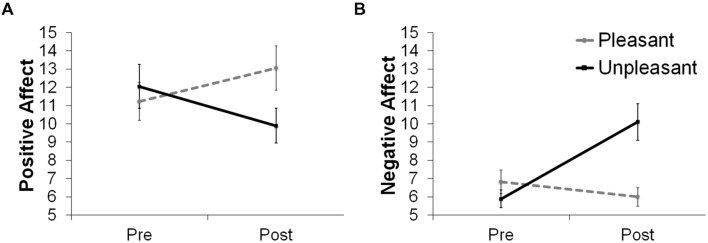
(A) Positive and (B) negative affect changes after listening to musical excerpts.